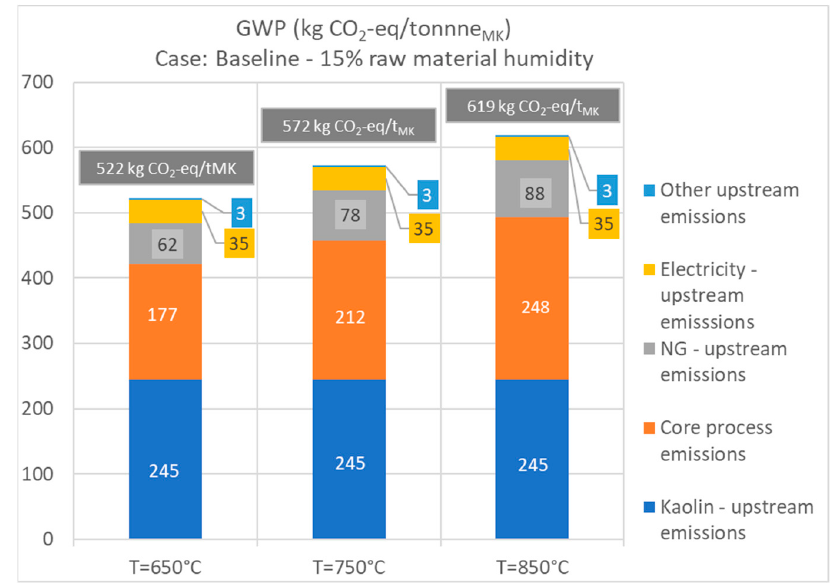
Figure 10. Influence of process temperature on the lifecycle GWP.